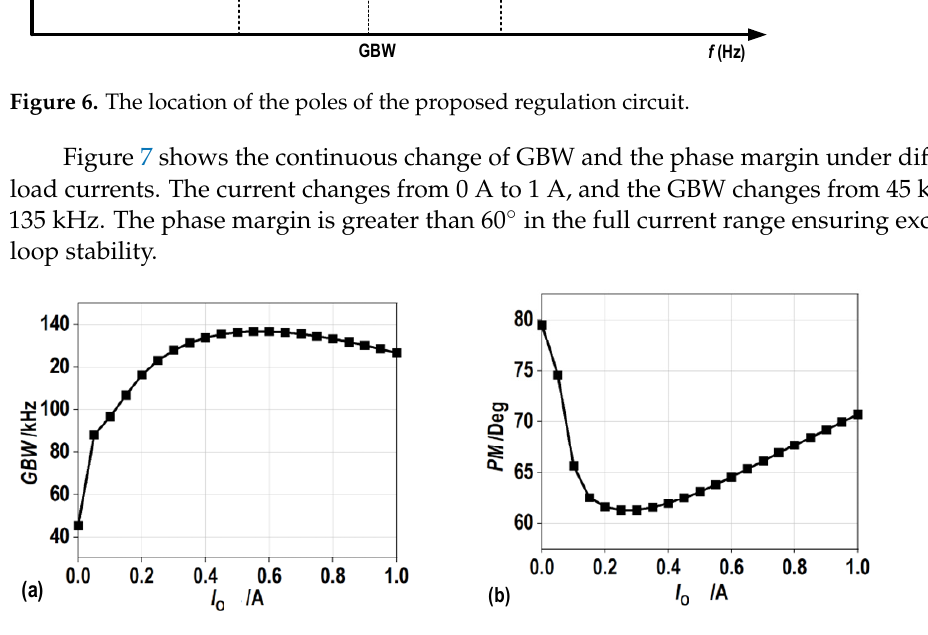
Figure 7. The simulation results of ( a ) GBW and ( b ) phase margin with IO from 0 A to 1 A.